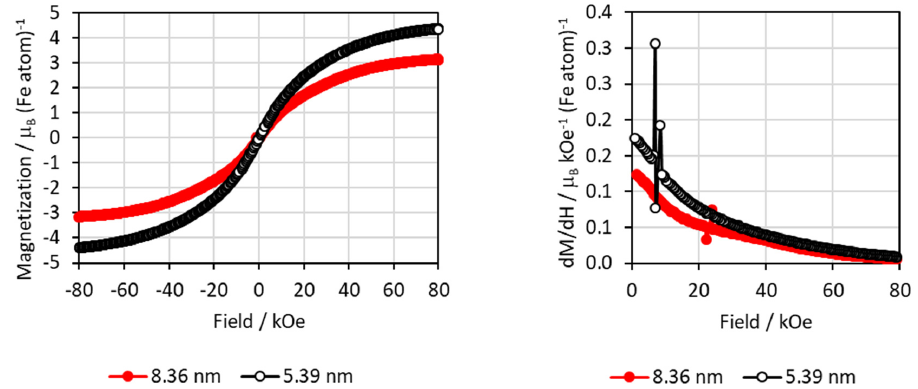
Figure 6. Magnetization ( left ) and first derivative ( right ) plots for [C 2 mim]FeCl 4 confined within mesoporous SBA-15 mesoporous SBA-15 silica.